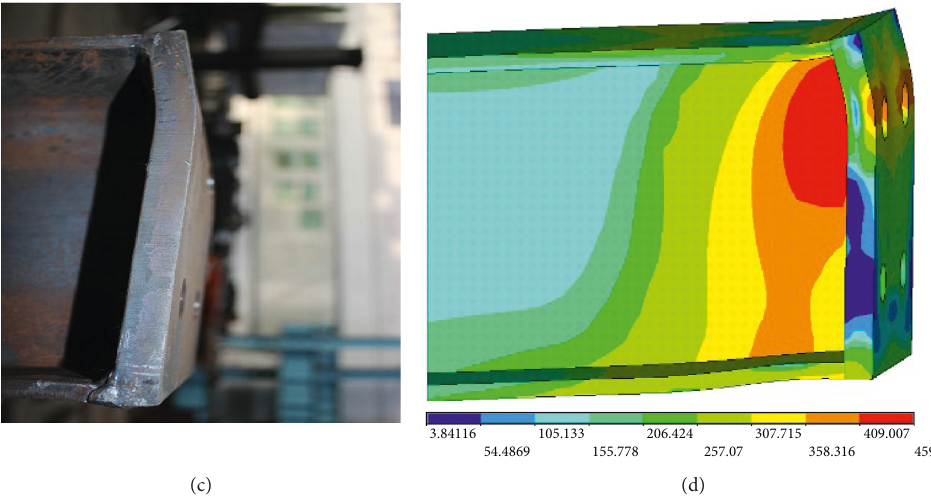
Figure 7: Comparisons of the final deformation. (a) Right connection of MZ-1 in the test. (b) Right connection of MZ-1 in the FE model. (c) Left connection of MZ-2 in the test. (d) Left connection of MZ-2 in the FE